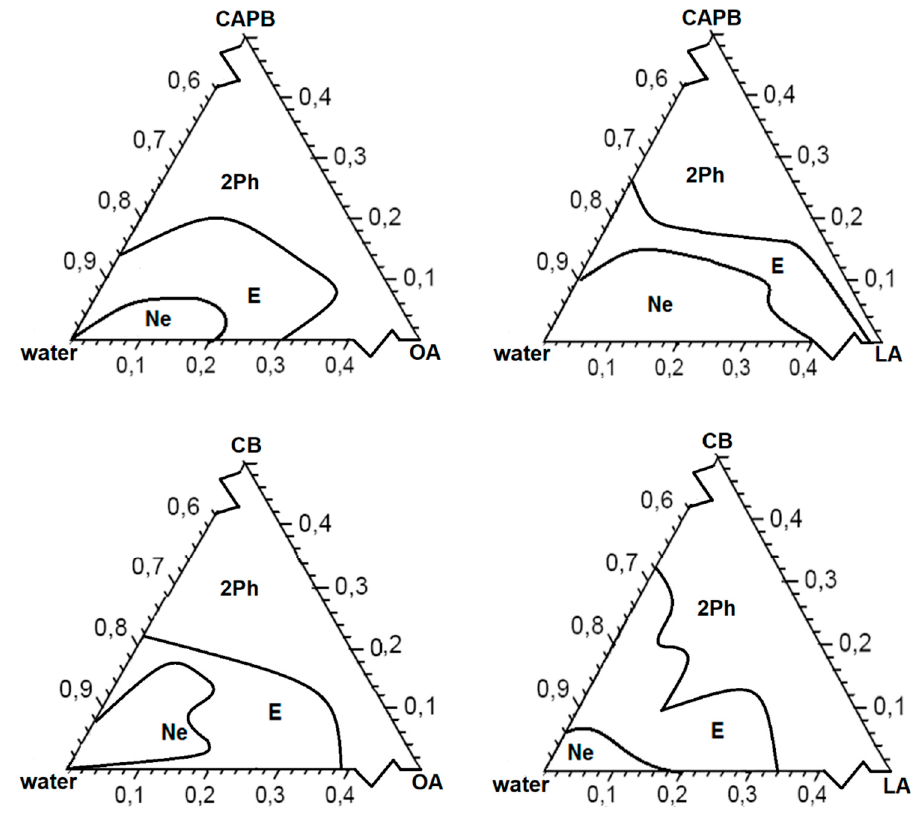
Figure 2. Partial phase diagrams of the obtained formulations stabilized with amphoteric betaine- type surfactants. Ne—oil-in-water type nanoemulsion (o/w), E—emulsion, 2Ph—double phases.